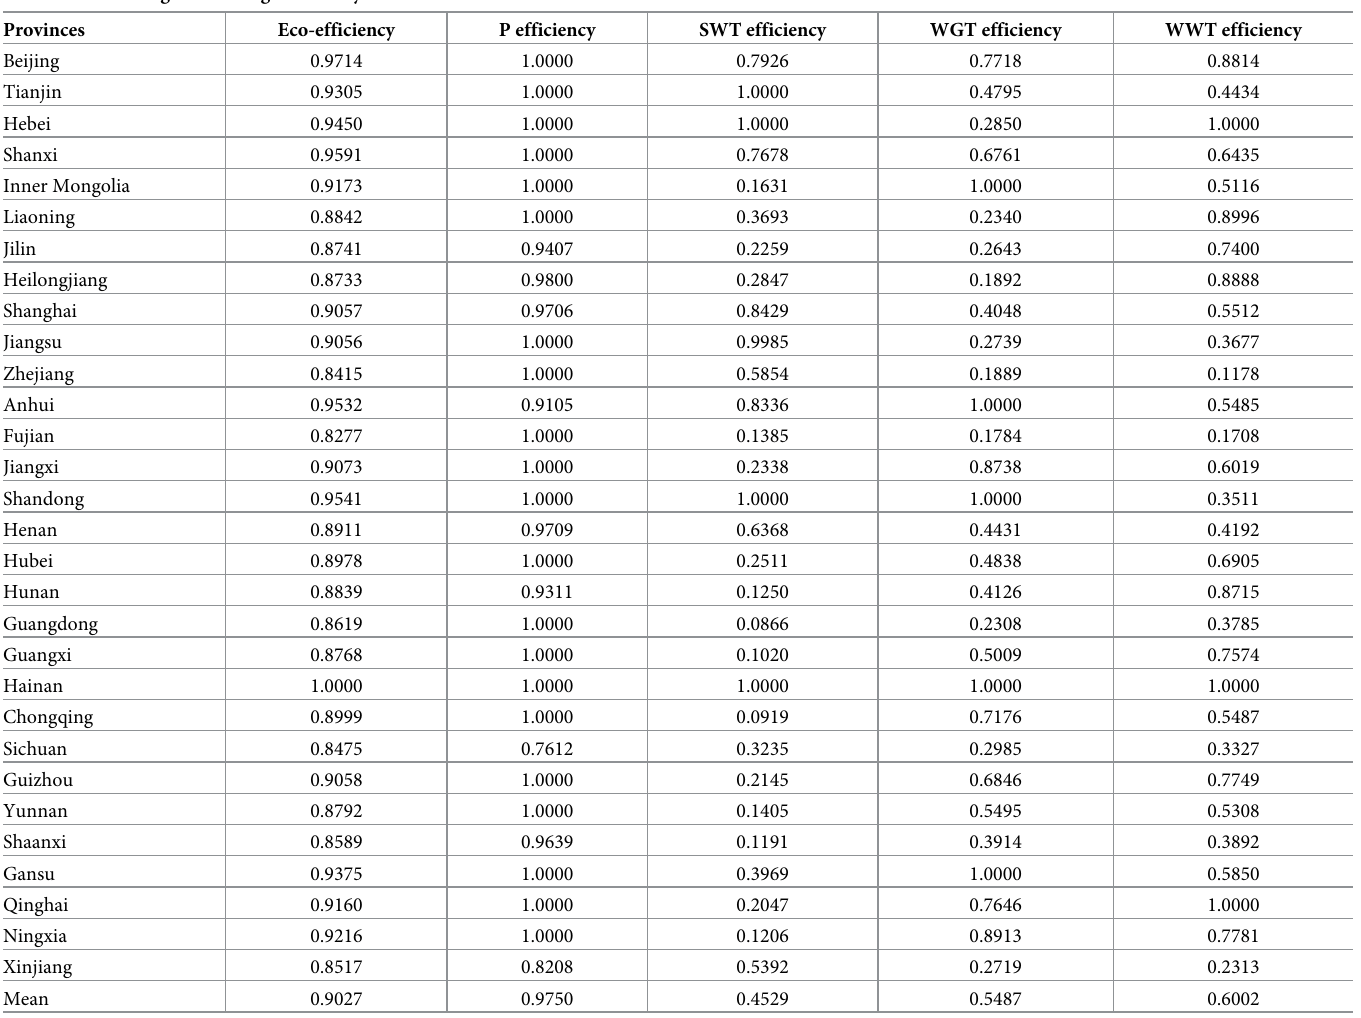
Table 3. Chinese regional average efficiency from 2011 to